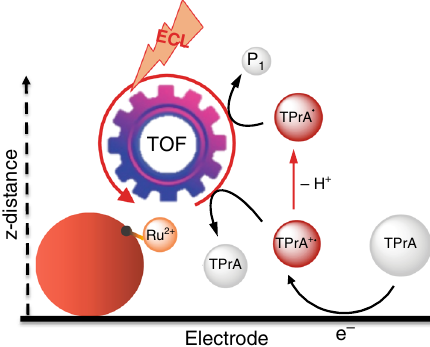
Fig. 1 Schematic representation of the remote electrochemiluminescence (ECL) mechanism. Tri- n -propylamine (TPrA) is oxidized at the electrode, generating the radical cation (TPrA • + ), which rapidly [half-life ( t 1/2 ), ∼ 200 µ s] deprotonates, forming the radical (TPrA • ). The radical and radical cation react with the ECL luminophore [Ru(bpy) 3 ] 2 + , tris(2,2 ′ - bipyridine)ruthenium(II) (Ru 2 + ), on the magnetic beads (red sphere), herein named surface generation – bead emission. The turnover frequency (TOF) is the number of photons emitted in 1 s by a single luminophore (see “ Supplementary Methods 1 ” (Fig. 1). In particular, the TPrA radical cation, with its limited lifetime [half-life ( t 1/2 ), ∼ 200 µs], is not expected to diffuse farther than 3 µm from the electrode surface 29 – 32 .